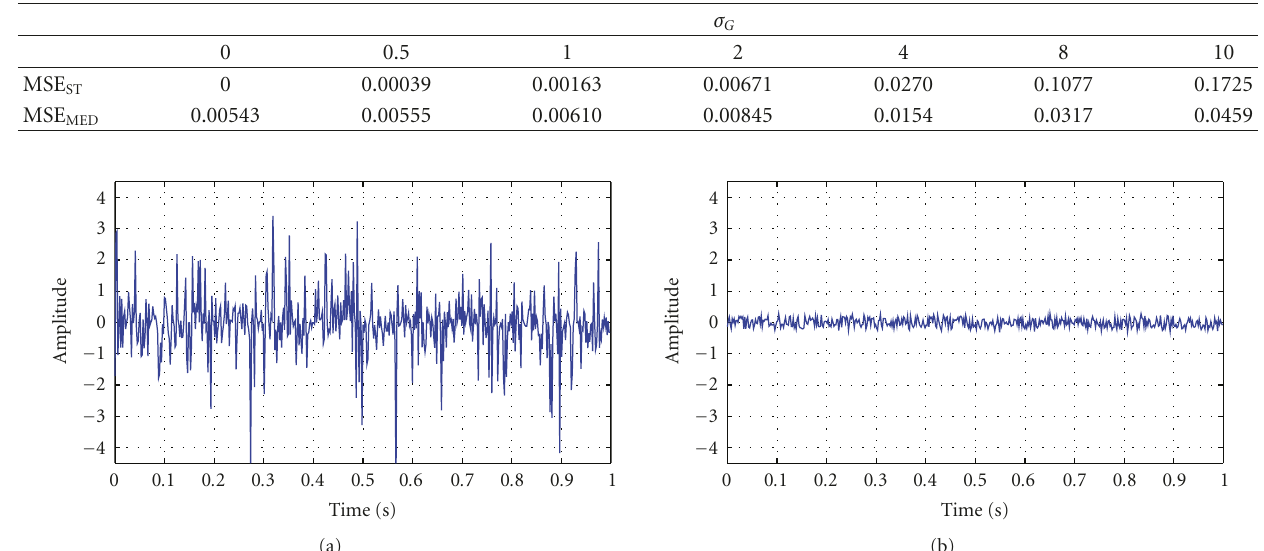
Table 2: MSE for signal s 2 ( n ) spectrum estimates obtained by standard DFT and RDFT method based on MED for the case of Gaussian noise with di ff erent values of σ G .